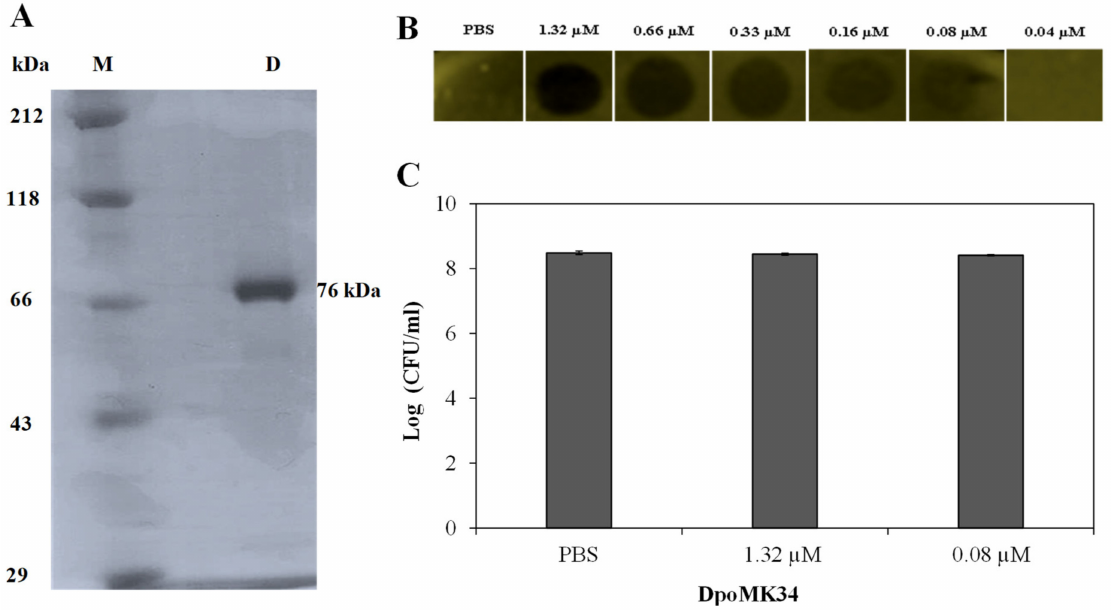
Figure 6. Activity of DpoMK34. ( A ) SDS-PAGE analysis of purified C-terminal 6 × His-tagged DpoMK34. Lane (M) represents Roti ® -Mark standard (Carl-Roth, Karlsruhe, Germany), whereas lane D represents purified DpoMK34. ( B ) Spot-on-lawn assay using different DpoMK34 concentrations on A. baumannii MK34 in the exponential growth phase. PBS pH 7.4 was used as control. ( C ) Bacterial counts from 4 × 4 mm excised squares treated with PBS, 1.32 µ M DpoMK34, and 0.08 µ M DpoMK34. Bars represent means ± standard deviation of three independent